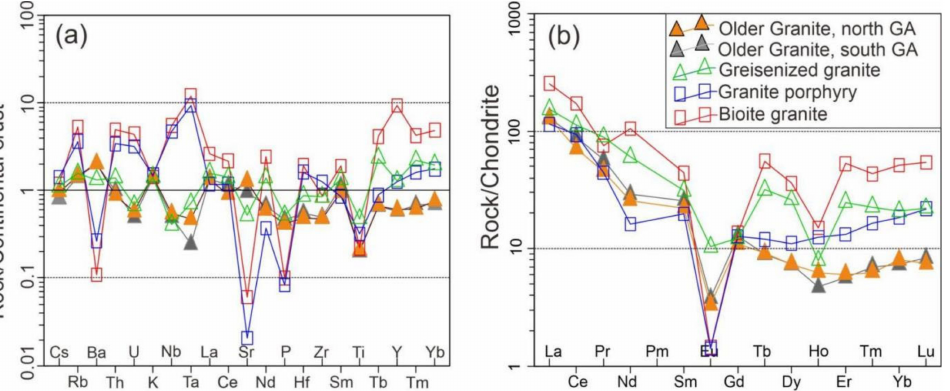
Figure 8. Distributions of trace elements and REE of the Older Granite, greisenized granite, and Younger Granite (including granite porphyry and biotite granite) from the Gindi Akwati deposit. ( a ) Spider diagrams of trace elements, Upper Continental Crust is according to [28]; ( b ) Chondrite- normalized REE distribution patterns, Chondrite is according to